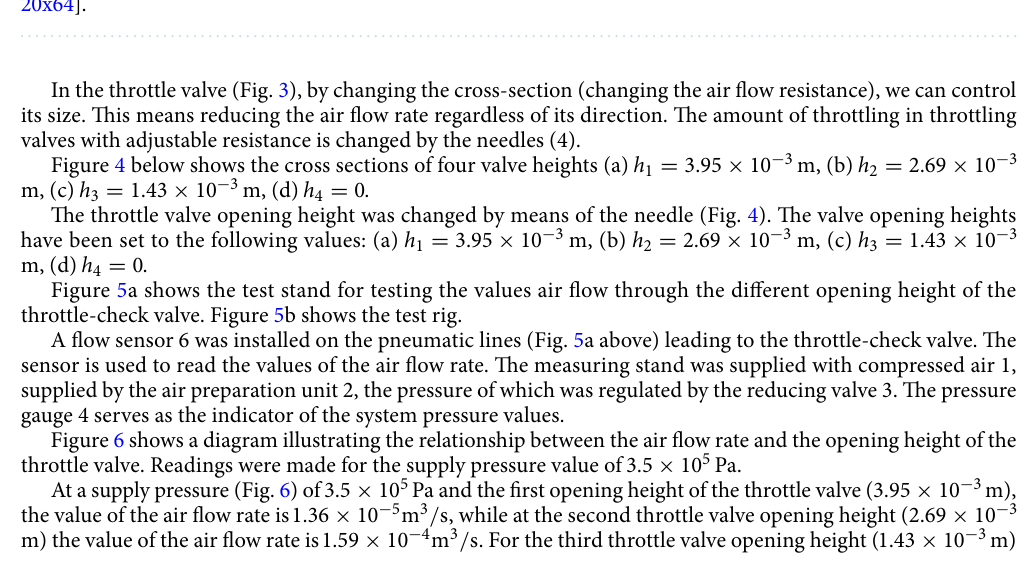
Figure 3. Cross section of the throttle check valve with the most important components. Where: 1—inlet channel, 2—drainage channel, 3—valve body, 4—control needle, 5—lower part of the control needle, 6—upper part of the control needle, 7—internal valve body, 8—external part of the control needle, 9—valve chamber, 10—channel choke, 11—drainage chamber [Ansys Fluent 2021 R2 (ANSYS Academic Research Mechanical and CFD): https:// downl oad. ansys. com/ Curre nt% 20Rel ease? relea seno= 2021% 20R2& opera tings ystem= Windo ws%